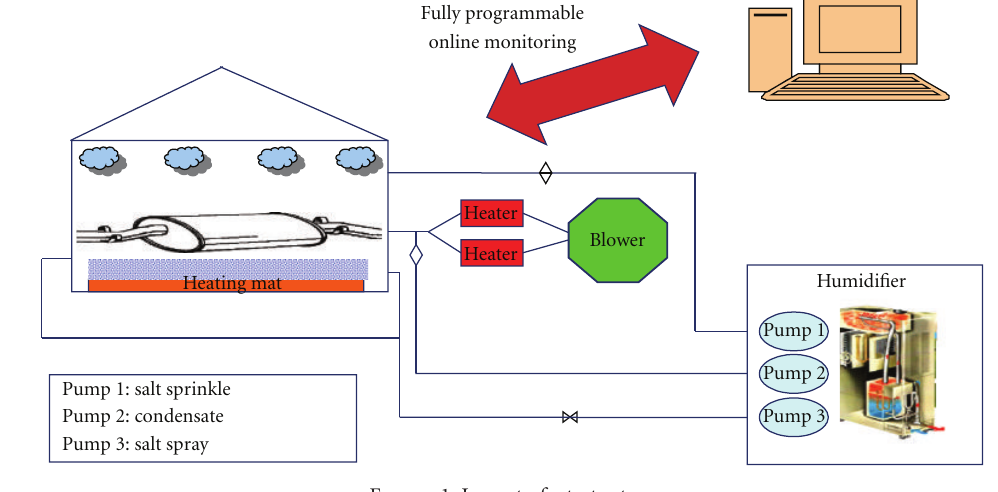
Figure 1: Layout of a test setup.